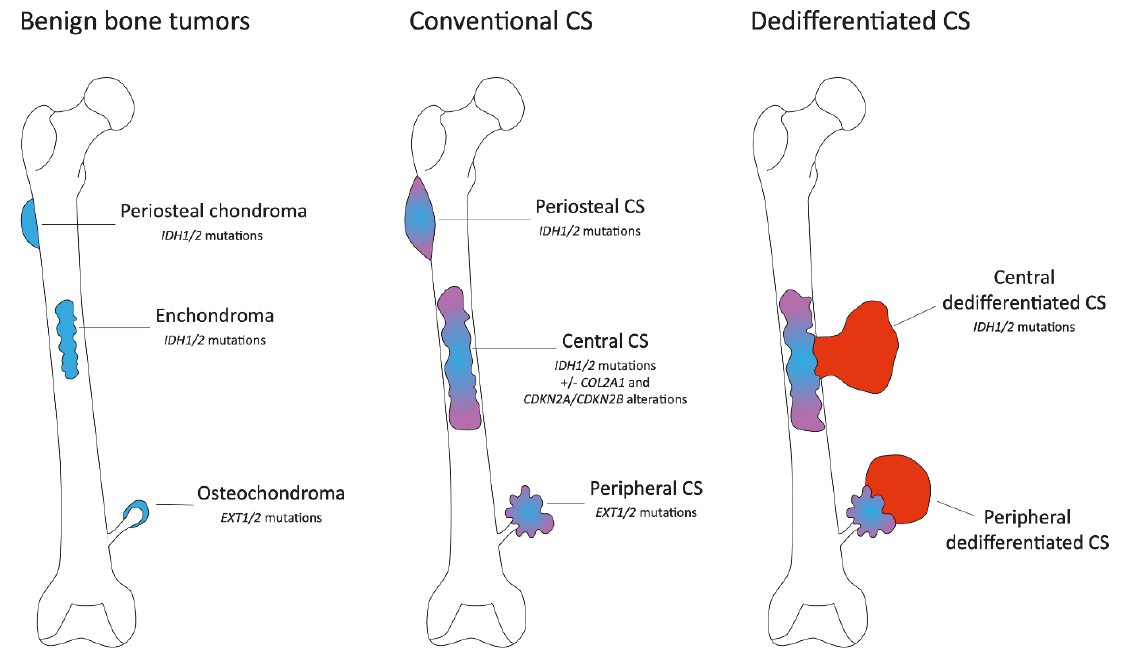
Figure 1. Schematic representation of conventional cartilaginous tumors of bone. The figure repre- sents the benign bone lesions, osteochondromas (sessile osteochondroma and pedunculated osteo- chondroma), chondromas (enchondroma and periosteal chondroma), their location, and the frequency of somatic tumors present in these lesions ( left part). These lesions may progress to malignant con- ventional chondrosarcomas ( middle part). To note, conventional chondrosarcomas may be primary or secondary tumors. In some cases, central and peripheral conventional chondrosarcomas may progress to dedifferentiated chondrosarcomas ( right